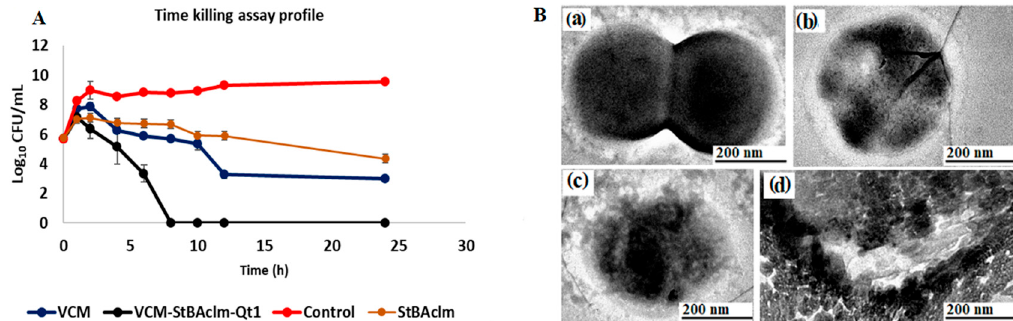
Figure 7. ( A ) Killing kinetics of MRSA exposed to 5 × MIC of VCM-loaded StBAclm-Qt1 quatsomes; VCM; bacteria in PBS 7.4 (positive control); the blank quatsomes (stBAclm); and sterile water (negative control) at di ff erent time intervals (n = 3); ( B ) HR-TEM images of ( a ) MRSA treated with VCM-loaded StBAclm-Qt1 quatsomes (5 × MICs), showing the membrane disruption that occurred after ( b )